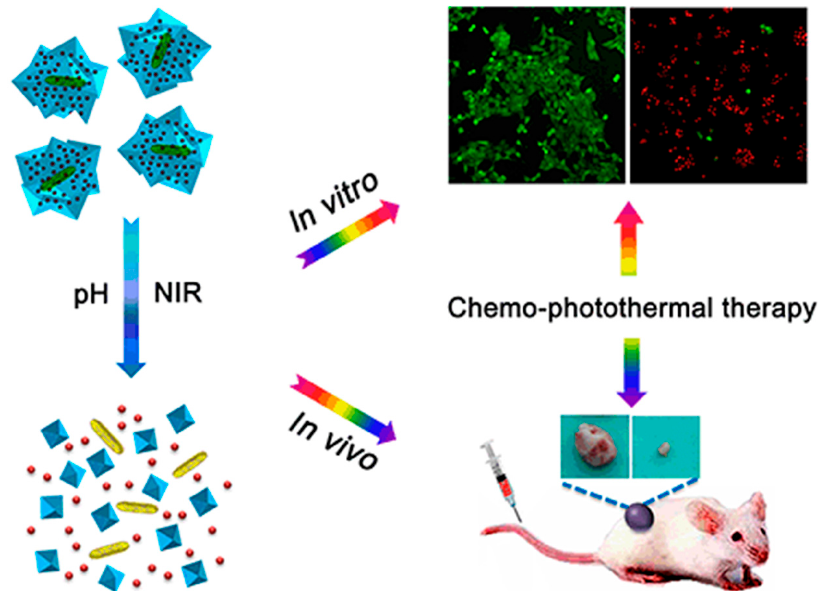
Figure 2. Crystalline zeolitic imidazolate framework-8 encapsulates doxorubicin hydrochloride and gold nanorods for synergistic chemo-photothermal therapy. The efficacy of chemo-photothermal therapy was demonstrated both in vitro and in vivo. Reproduced with permission from [48]. Copyright © 2017, Tsinghua University Press and Springer-Verlag GmbH Germany, part of Springer Nature.